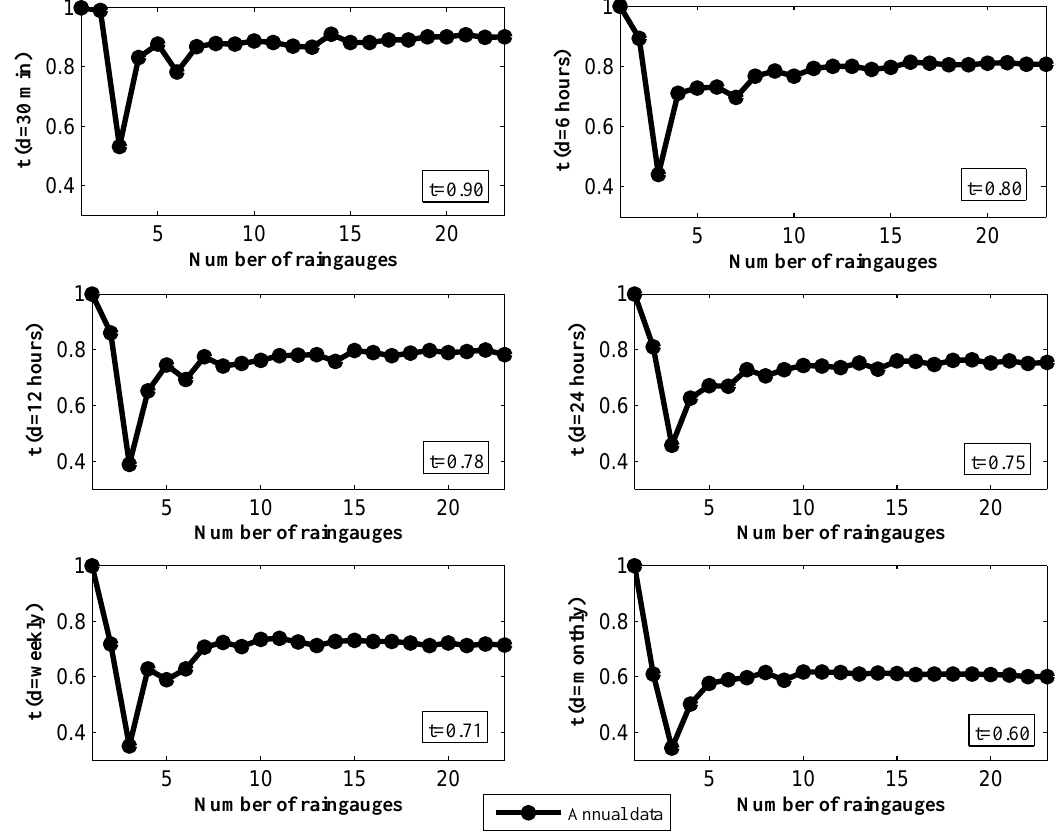
Fig. 4. Coefficient of nontransferred information for sampling time intervals of d = 30min, 6, 12, 24h, 1 week and 1 month for annual data in Rome. The maximum content of non-redundant information is quoted in the box for each sampling time. This result is the value assumed by t , corresponding to the last raingauge added to the network. The same values are presented on a semi-log scale in Fig.